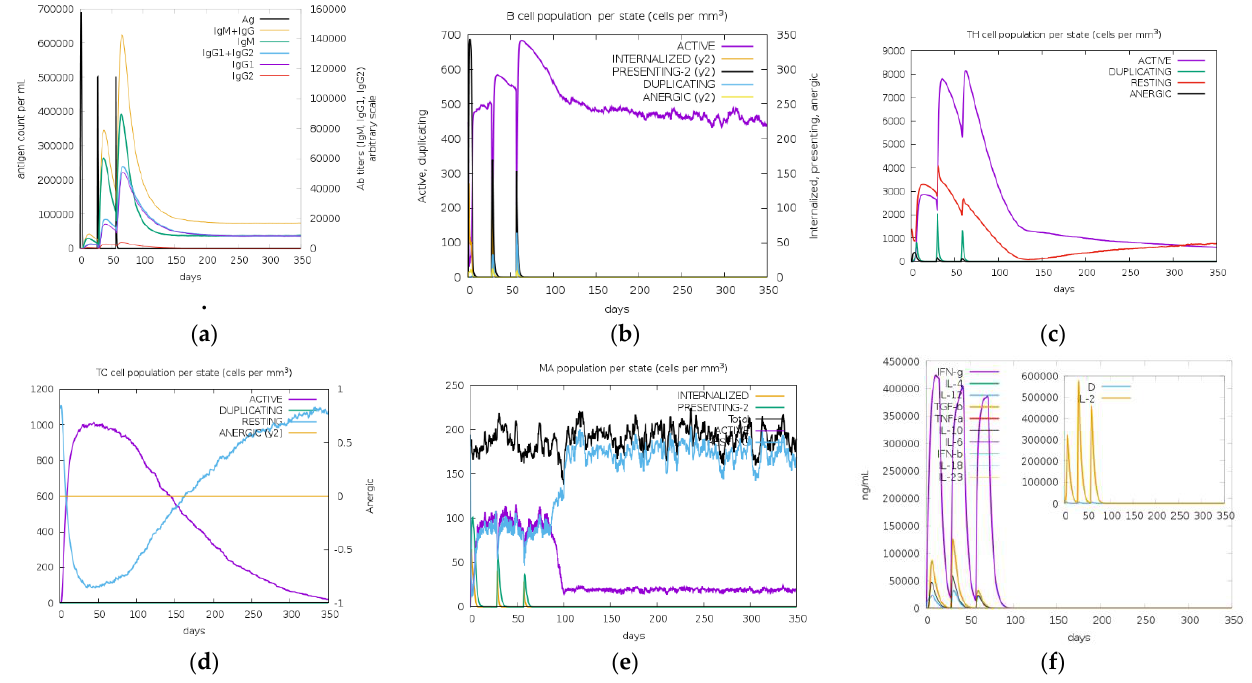
Figure 9. In silico immune simulation of UGM002 vaccine using the C-ImmSim server. Antigen and immunoglobulins ( a ), B cell population ( b ), TH cell population ( c ), TC cell population ( d ), macrophage population ( e ), production of cytokine and interleukins with Simpson index ( f ).